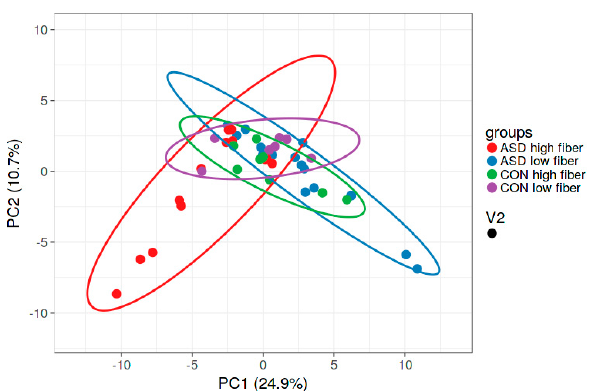
Figure 7. Visualisation of intestinal microbiota diversity at genera level of neurotypical children and children with ASD with high or low daily fibre intake (ClustVis).